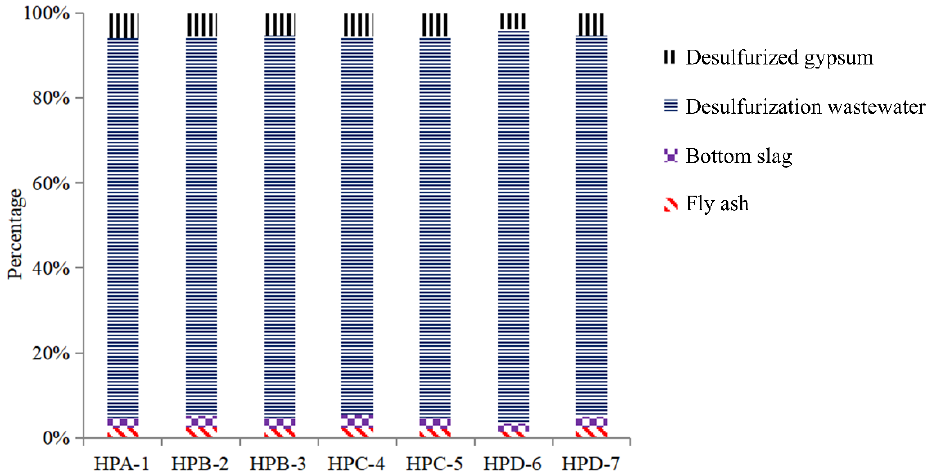
Figure 3. Distribution of chlorine in non-gas by-products of coal . Table 5. Person Correlation Analysis between Cl and Coal Quality in Coal.